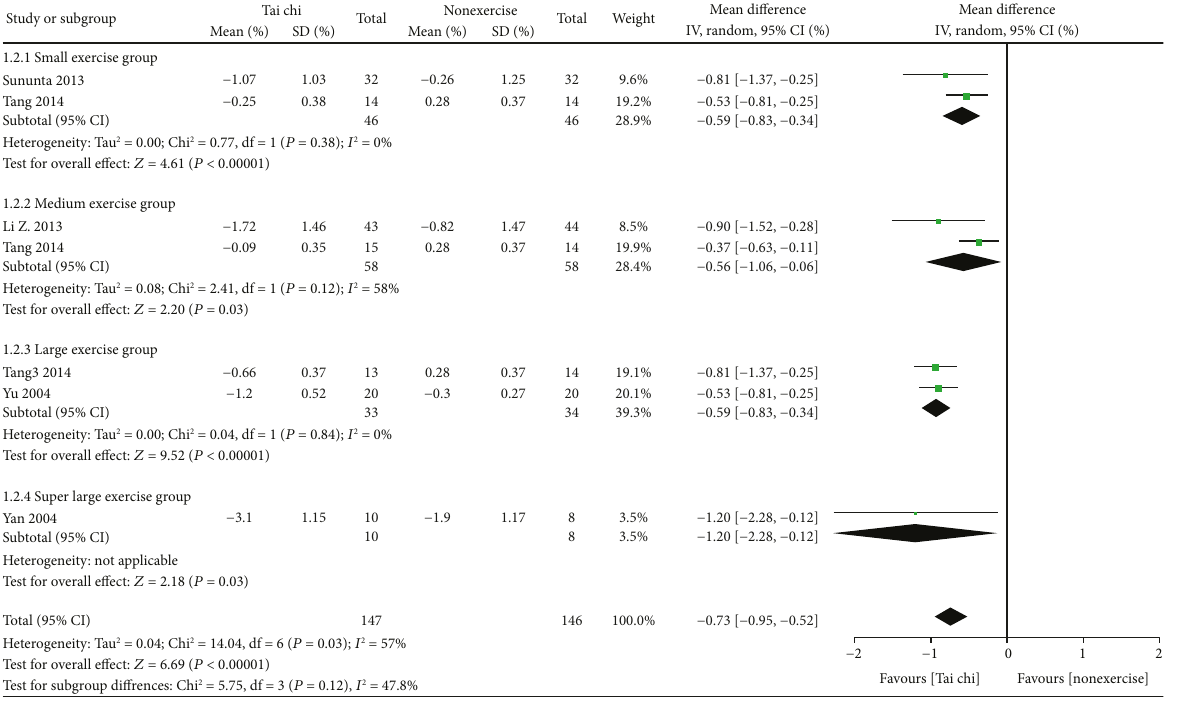
Figure 4: The meta-analysis for comparing HbA1c between Tai chi and the nonexercise. CI: con fi dence interval; SD: standard deviation. Study or subgroup